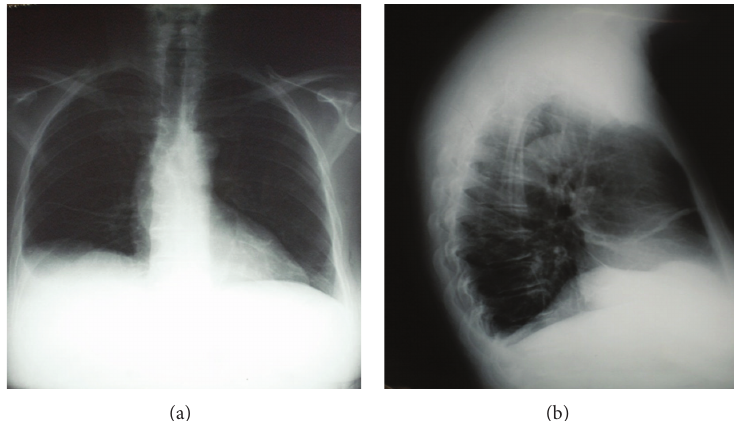
Figure1:A57-year-oldwomanwithdiffuselargeB-celllymphomaandperitoneallymphomatosischestradiographyshowsright-sidedpleural effusion without mediastinal enlargement or other significant abnormalities.